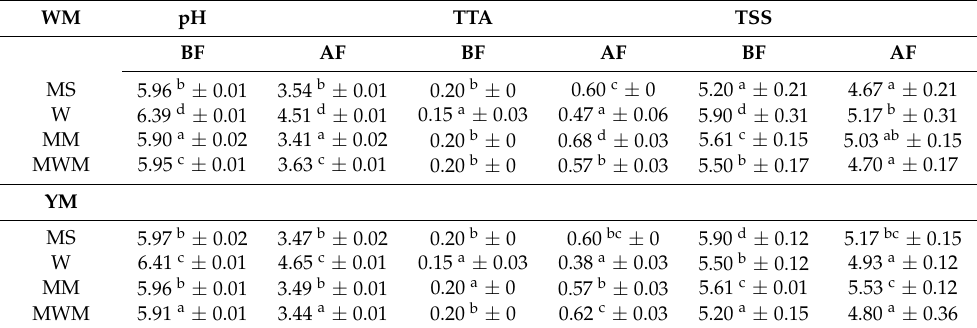
Table 4. Experimental values obtained for white and yellow maize mahewu